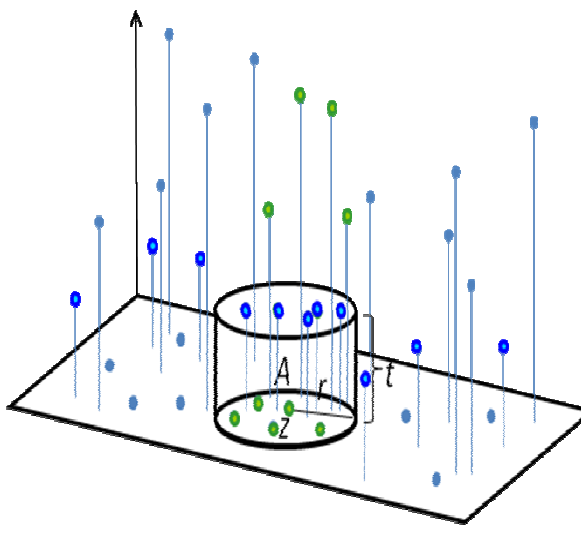
Figure 3. Cluster illustration of the spatial-temporal model